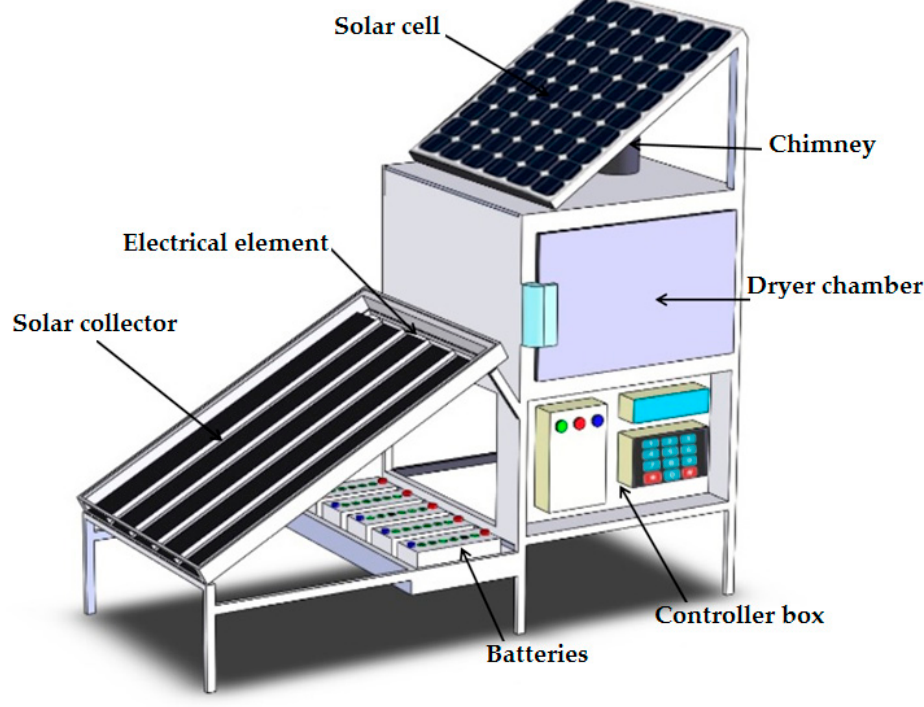
Figure 1. Dryer diagram used.